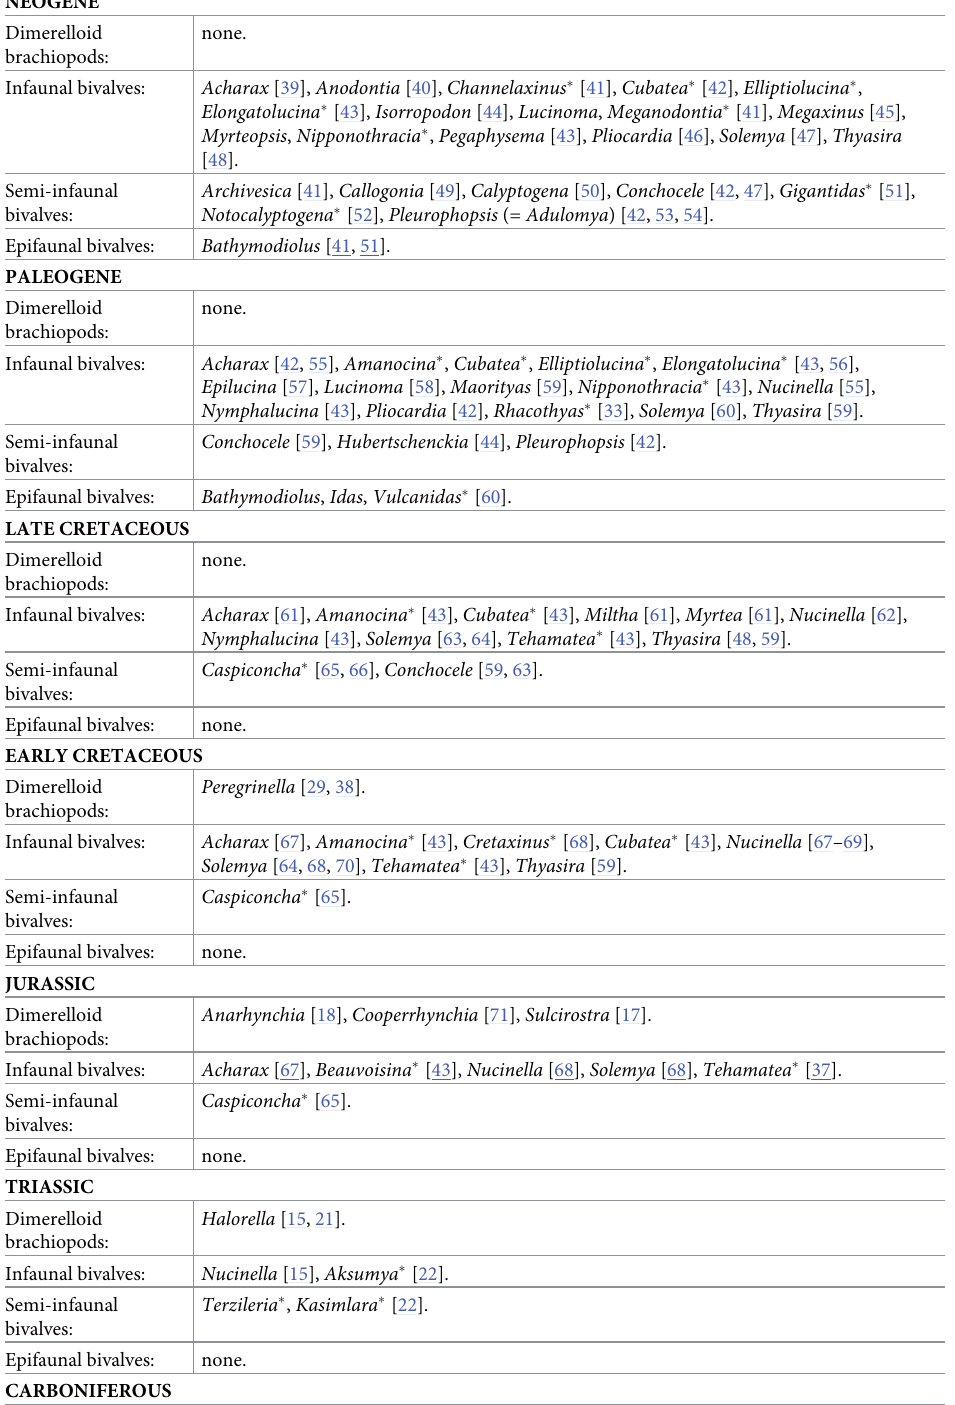
Table 1. Dimerelloid brachiopod genera and (inferred) chemosymbiotic bivalve genera in ancient hydrocarbon- seep deposits. New brachiopod and bivalve genera established since Mike Sandy’s review of dimerelloid brachiopods as seep-inhabitants in 1995 [23] are marked by an asterisk ( � ); see section ‘Diversity pattern’ for